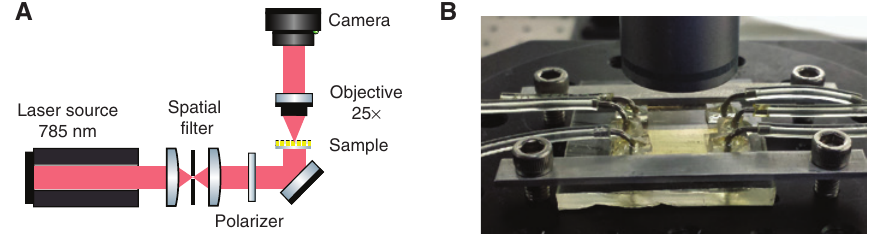
Figure 3: Optical setup and microfluidic chip. (A) The optical setup consists of a homemade microscope with a monochromatic laser diode source, a spatial filter, and a polarizer. The microscope objective was 25 × . (B) The polydimethylsiloxane microfluidic chip with three parallel